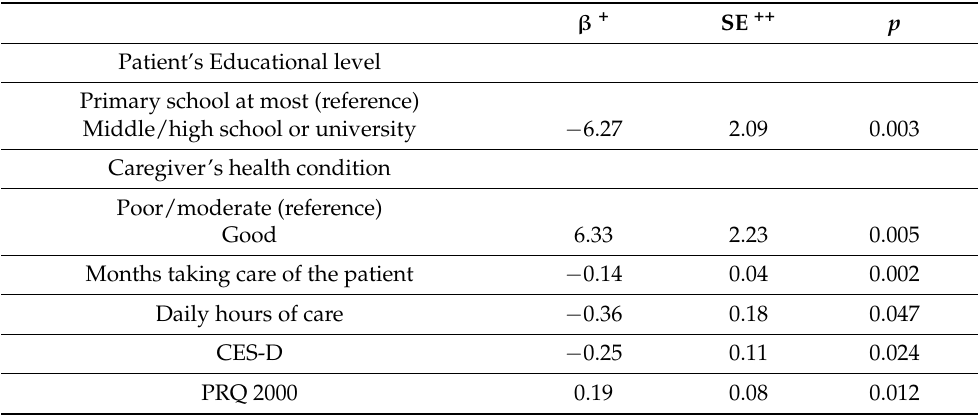
Table 5. Multiple linear regression analysis results with Greek BCOS as dependent variable, patients’ and caregivers’ characteristics, Barthel Index, CES-D, and PRQ 2000 as independent variables, using stepwise